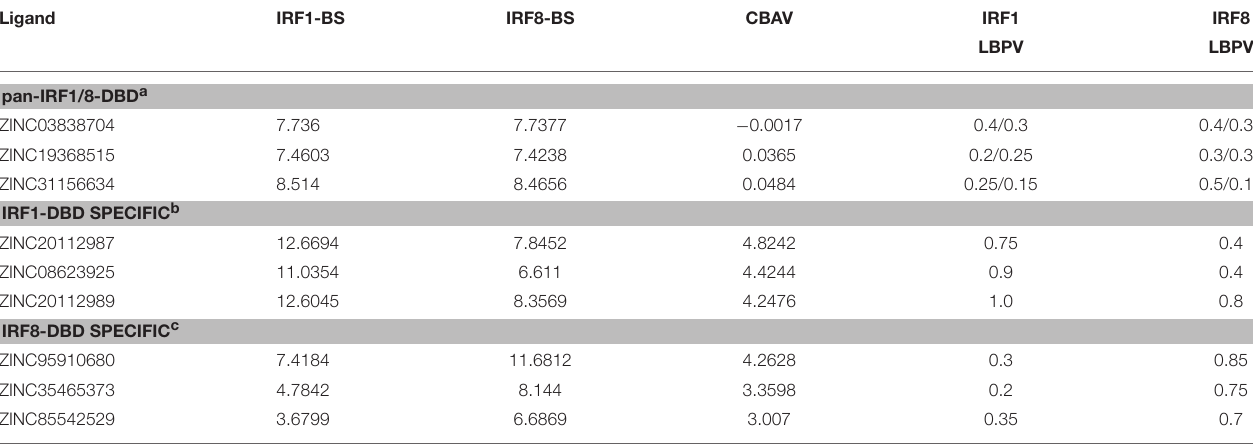
Comparative docking characteristics: pgeom algorithm, CBAV and LBPV of top selected compounds from Natural Products screen bound to IRF1- and IRF8-DBD domain. In silico calculations were performed by Surflex-Dock 2.6. BS, binding score; CBAV, comparative binding score value; LBPV, ligand binding pose